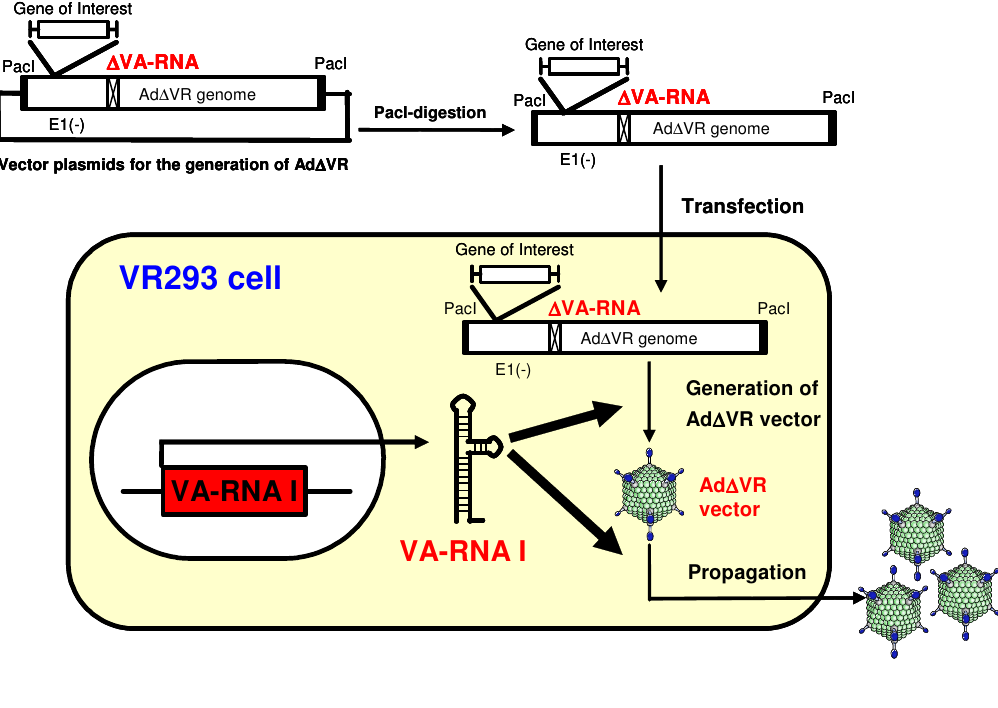
Figure 3. Generation of Ad ∆ VR vectors using VR293 cells. VA-RNA I-expression in VR293 cells allows the generation and the subsequent propagation of VA-RNA-deleted Ad (Ad ∆ VR)